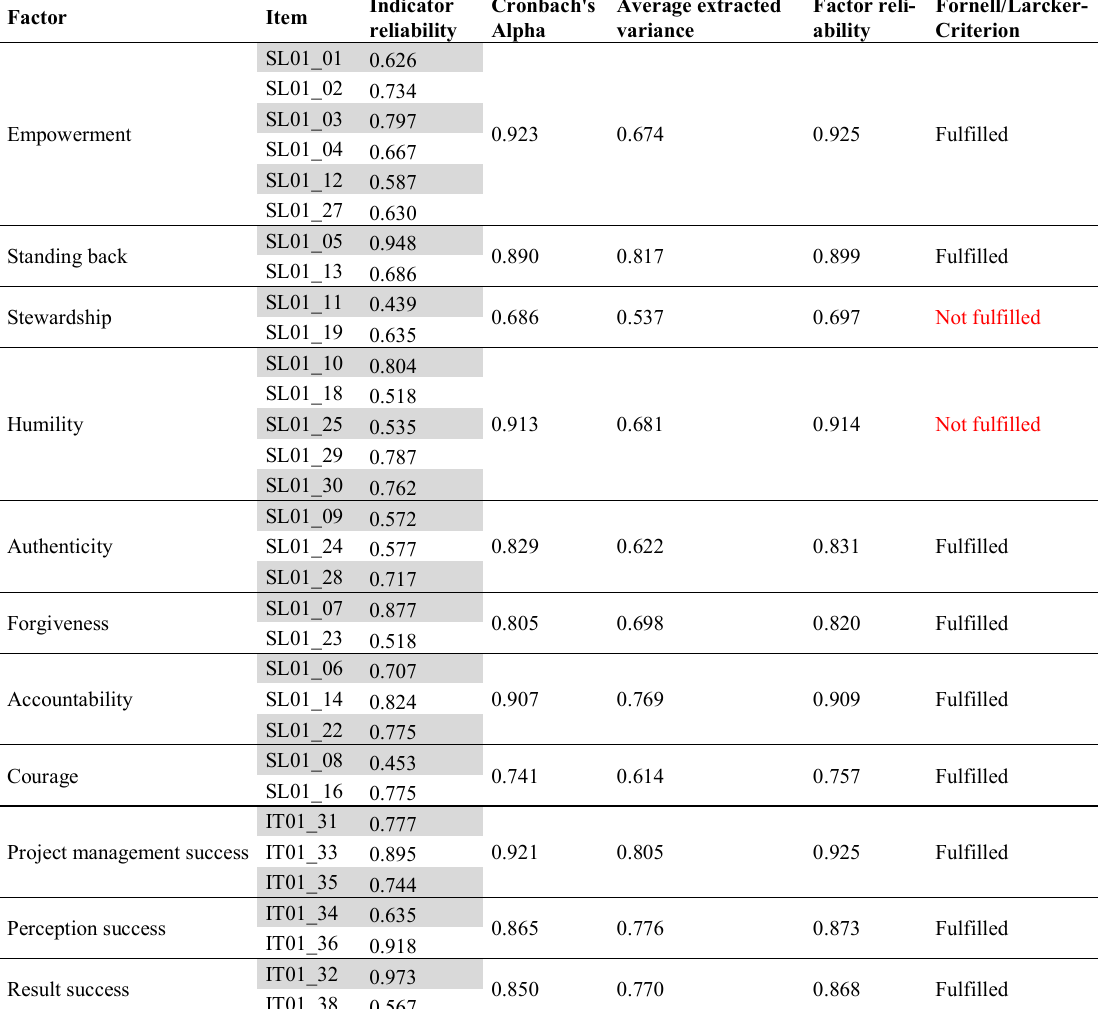
Value criteria on construction level of final effect